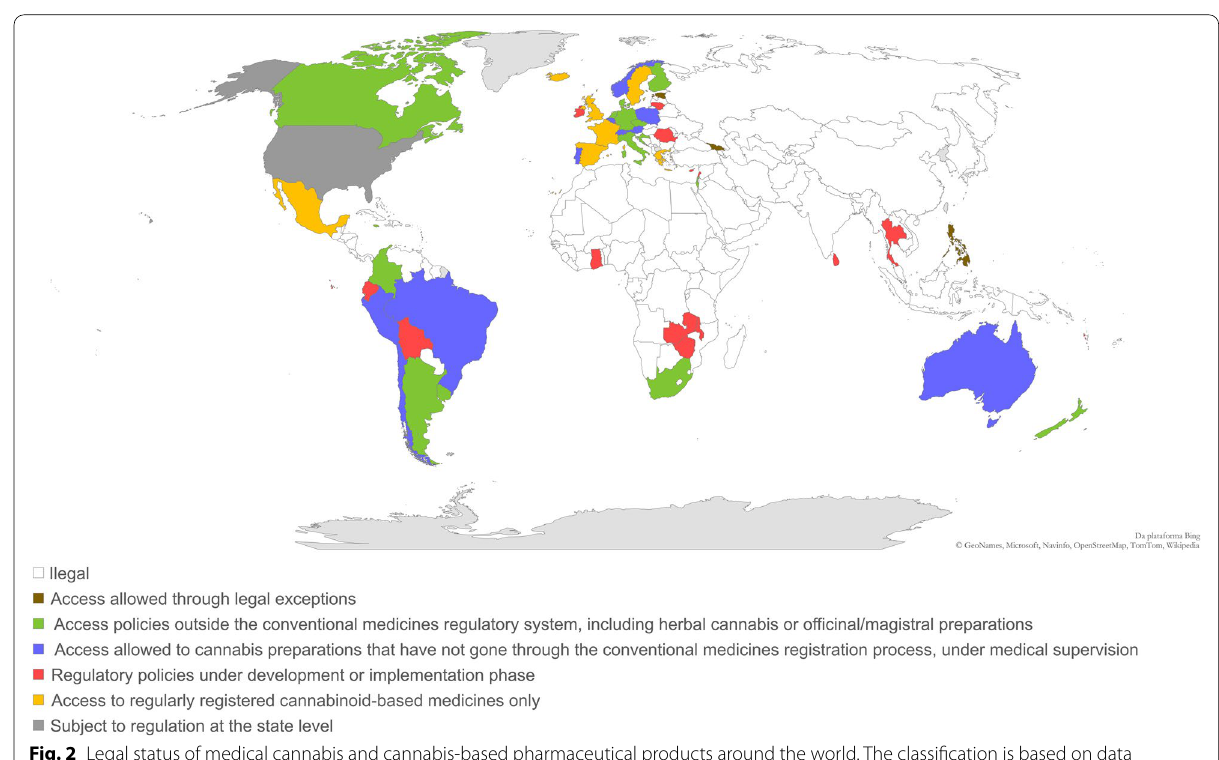
Fig. 2 Legal status of medical cannabis and cannabis-based pharmaceutical products around the world. The classification is based on data obtained from October 2020 to March 2021. The sources of the original information regarding the assessed models are listed in the supplementary